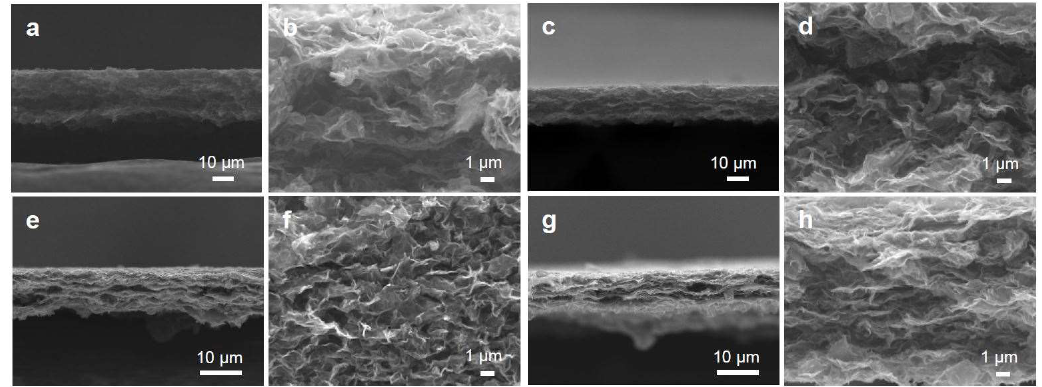
Figure 7. SEM images of cross sections of the fabricated rGO papers after sonication treatments for ( a , b ) 6, ( c , d ) 10, ( e , f ) 14, and ( g , h ) 20 h.